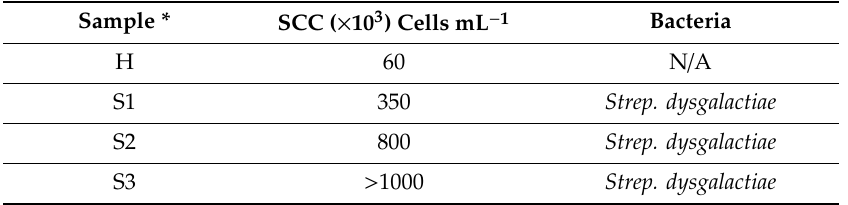
Table 1. Infection status and somatic cell count (SCC) values of the analyzed milk samples.